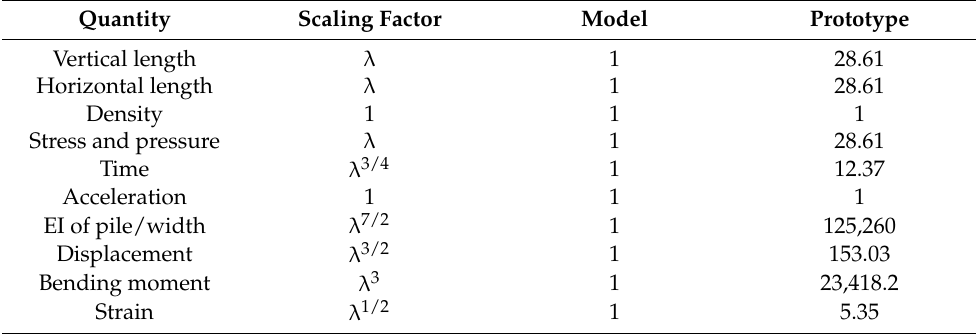
Table 1. Generalized scaling law for model tests.